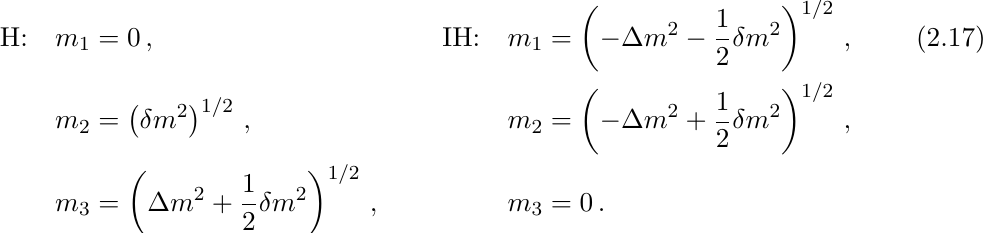
, sin 2 (cid:18) , and sin 2 (cid:18) , 12 13 23